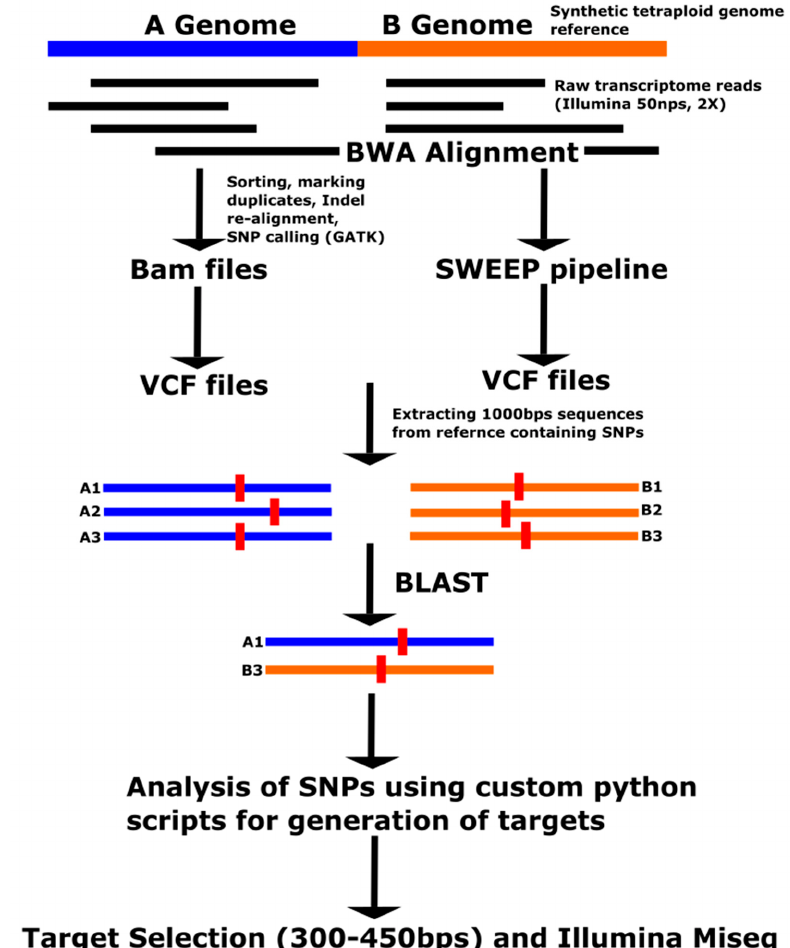
Figure 1. GATK pipeline for SNP identification and target selection (for the OLin method, the SNP identification pipeline would be the same expect for the alignment with the OLin transcriptome sequence instead of the synthetic tetraploid genome